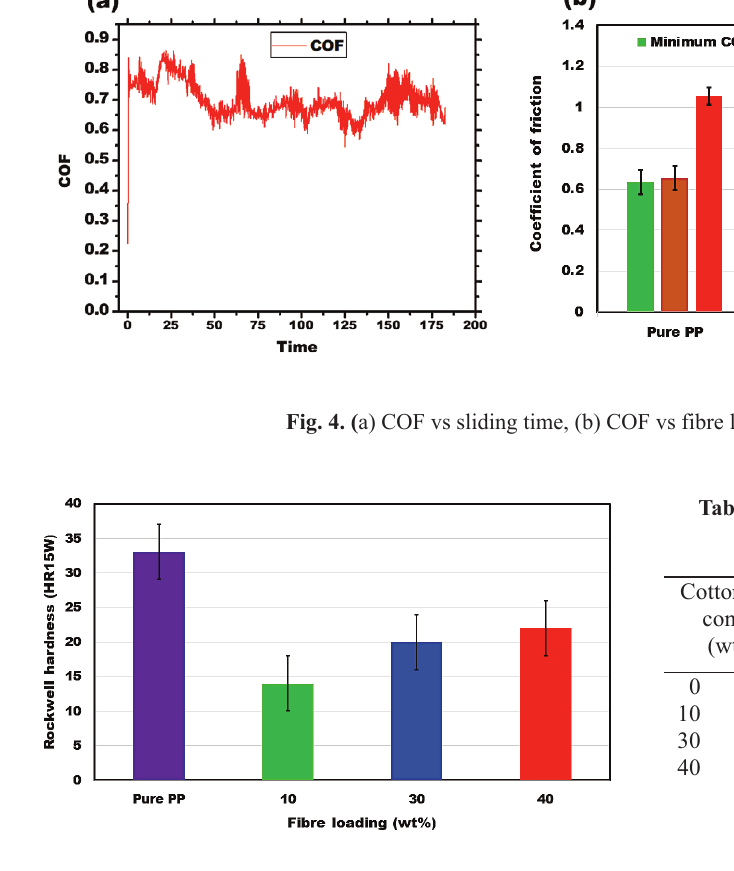
Fig. 5. Rockwell hardness and fibre loading relationship.